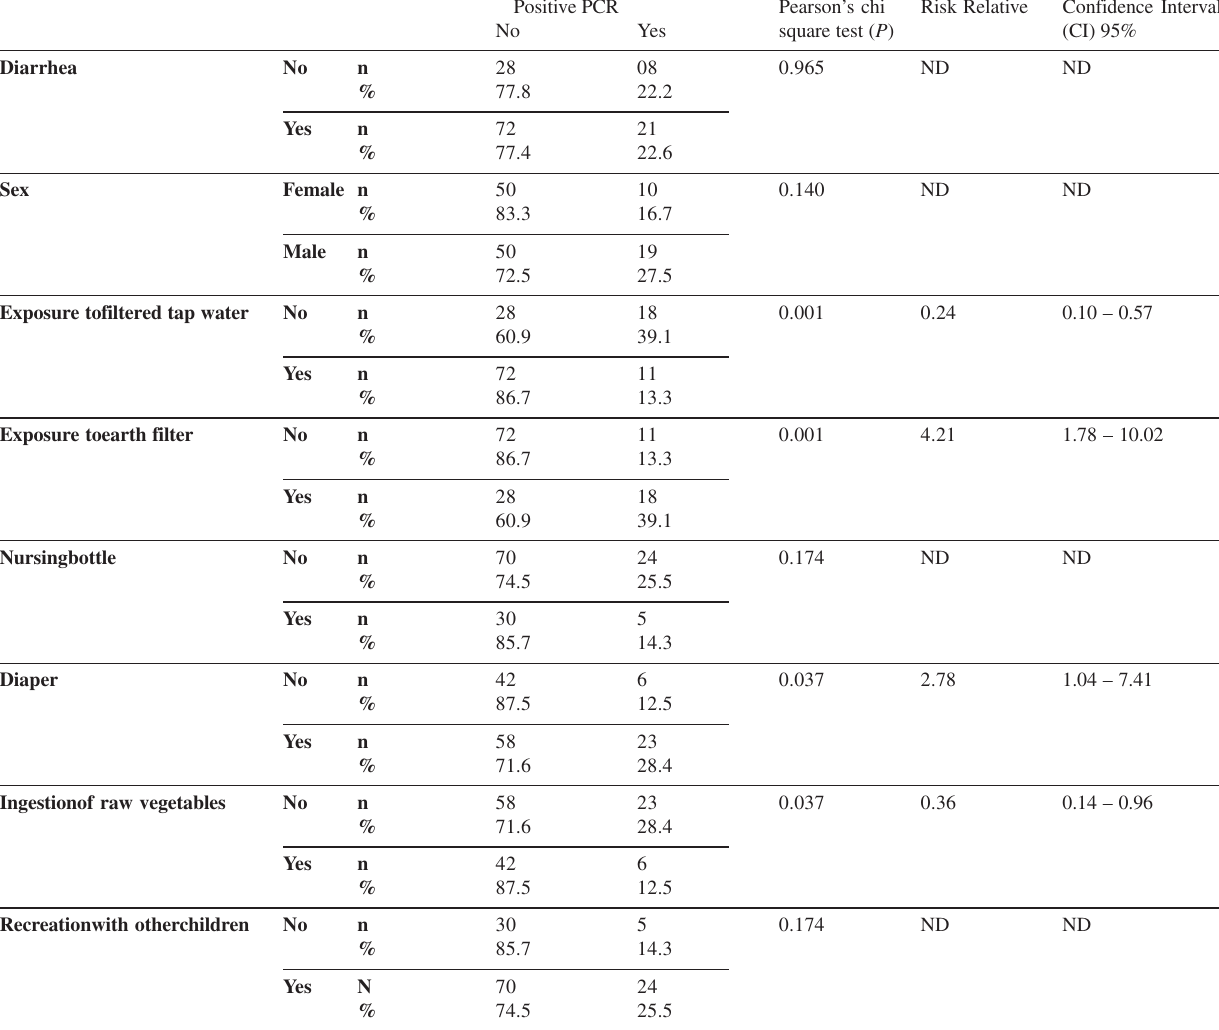
Table 3 - Association between positive results for Cryptosporidium hominis and some risk